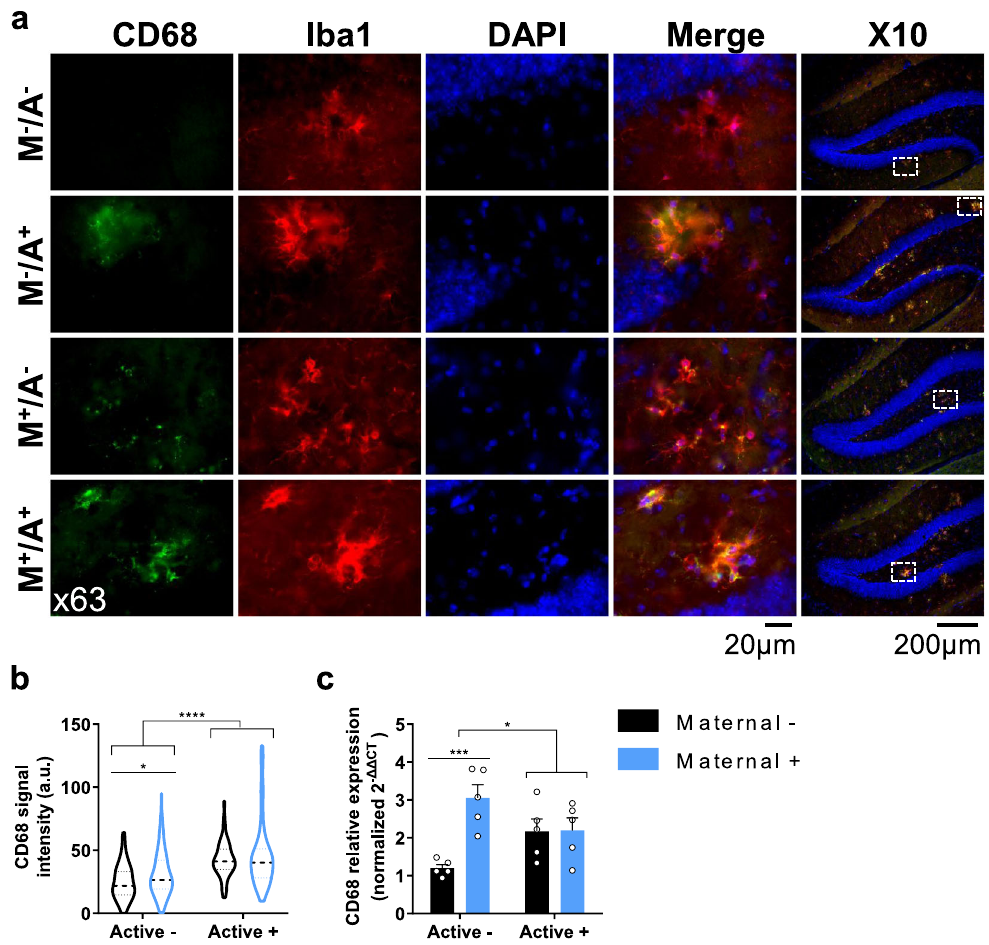
Fig. 8 Maternal vaccination enhances microglial phagocytosis. Microglia reactivity in the hippocampus was assessed using double labeling of CD68 and Iba1 + microglia following maternal and active vaccination at 5 m of age ( n = 5 ). a Double labeling of CD68 and Iba1 + microglia using the x10 and x63 objectives for visualizing and quanti fi cation, respectively. b Quanti fi cation of CD68 signal intensity, lines represent the median and the 25, 75 percentiles. c CD68 mRNA levels were measured using RT-qPCR. * P < 0.05, *** P < 0.001, **** P < 0.0001, two-way ANOVA, data are presented as mean ±